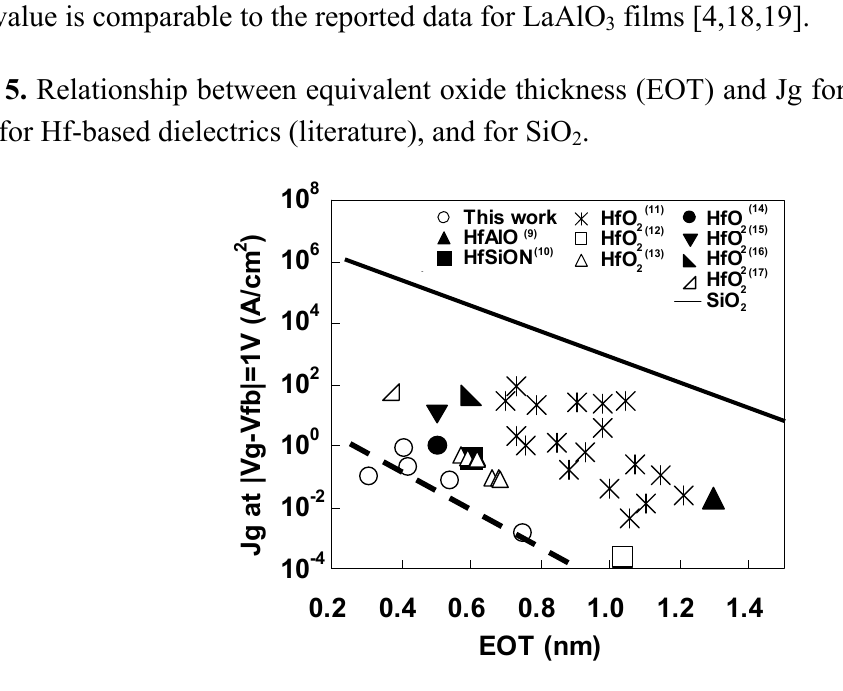
Figure 6. XPS O 1s loss spectrum for 10-nm LaAlO